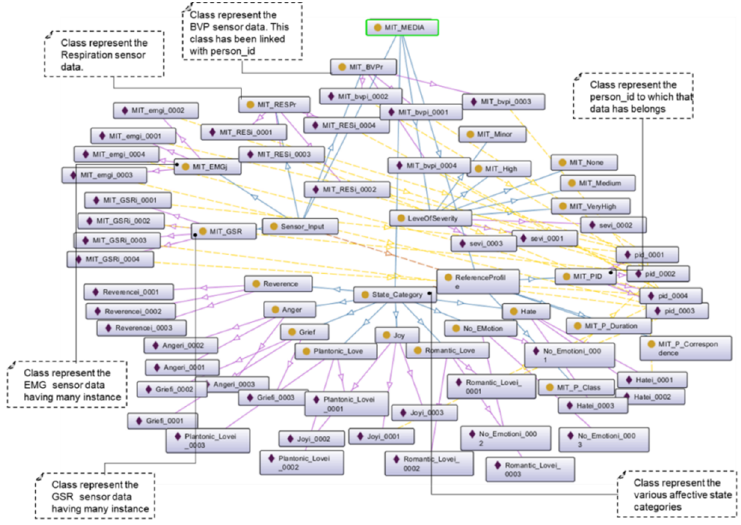
Figure 21. Semantic dataset A ontology.